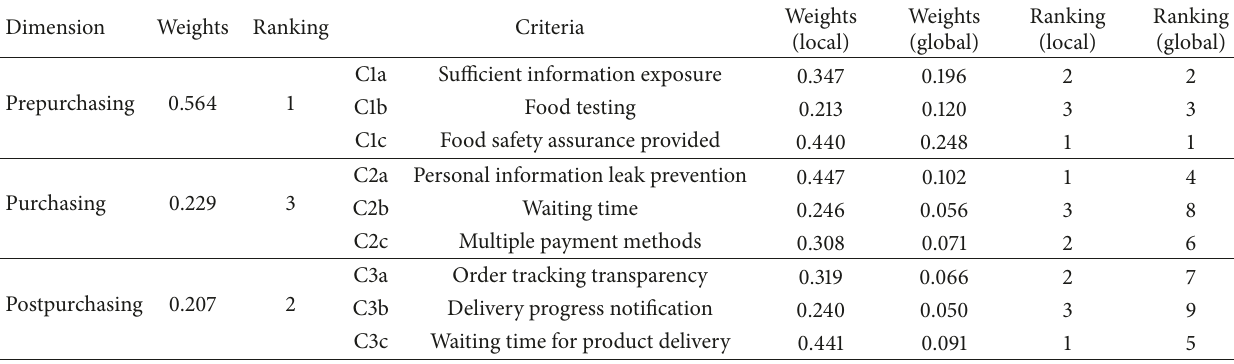
Table 7: Decision-making dimension and transaction cost factors weights.